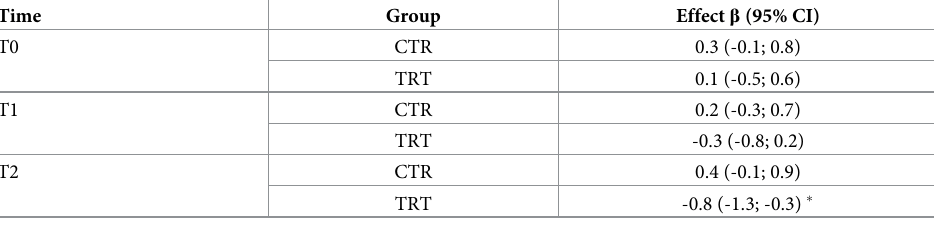
Table 4. Effect ( β ) of time on signs of OA scores recorded in the two groups (CTR and TRT) estimated by the per- formed